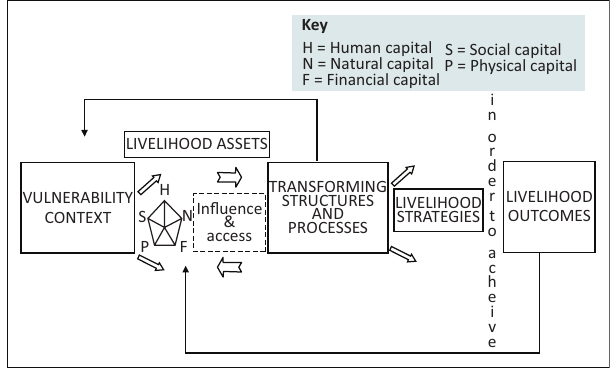
FIGURE 1: The sustainable livelihoods